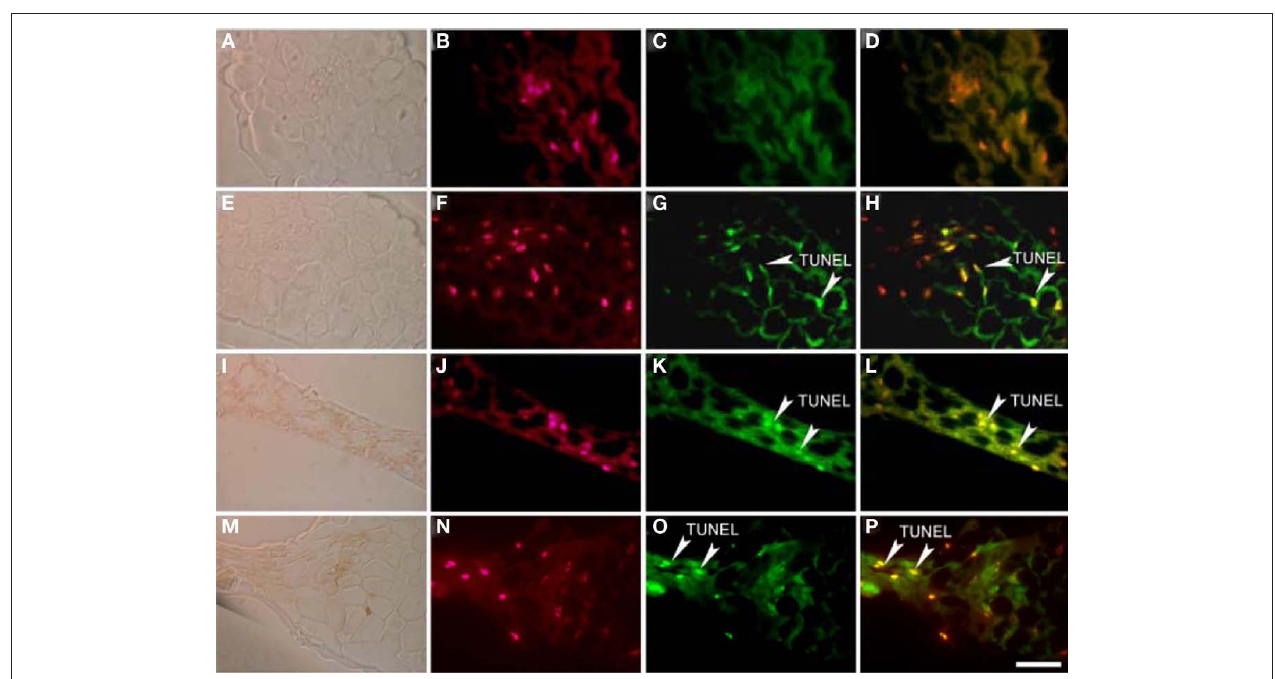
FIgURe 10 | TUNeL staining in necrotic spots. Transmitted light images (A,e,I,M) , sytox orange nuclear staining (B,F,J,N) and TUNEL staining (C,g,K,O) on cross-sections of 5-week-old wild-type (A–D) , and sns-D leaves (I–L) . As positive controls, DNase I-treated cross-sections of wild-type (e–H) and sns-D leaf (M–P) are shown. (D,H,L,P) are merged images of (B) with (C), (F) with (g), (J) with (K), (N) with (O) , respectively. TUNEL-positive nuclei are indicated by arrows. The bar is 25